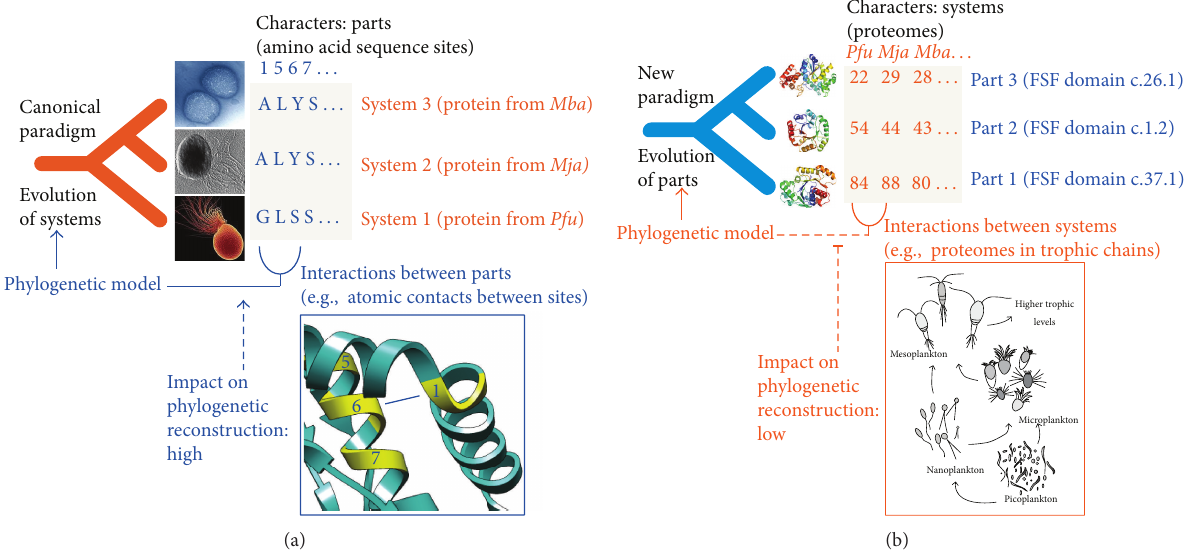
Figure 5: A new phylogenetic strategy simplifies the problems of character independence. (a) The canonical paradigm explores the evolution of systems, such as the evolution of organisms in the reconstruction of ToLs. For example, the terminals of phylogenetic trees can be genes sampled from different organisms (e.g., Pyrococcus furiosus ( Pfu ), Methanococcus jannaschii ( Mja ), and Methanosarcina barkeri ( Mba )), and phylogenetic characters can be amino acid sequence sites of the corresponding gene products. Character states can describe the identity of the amino acid at each site. Since characters are molecular parts that interact with other parts when molecules fold into compact 3D structures, their interaction violates the principle of character independence. Consequently, the effects of covariation must be considered in the phylogenetic model used to build the trees. (b) The new paradigm explores the evolution of parts, such as the evolution of protein domains in proteomes. For example, the terminals of phylogenetic trees can be domains defined at fold superfamily level of structural complexity and the characters used to build the trees can be proteomes. Character states can be the number of domains holding the FSF structure. Since proteomes interact with other proteomes when organisms establish close interactions, interactions that could affect the abundance of domains in proteomes should be considered negligible (unless there is an obligate parasitic lifestyle involved) and there is no need to budget trophic interactions in the phylogenetic